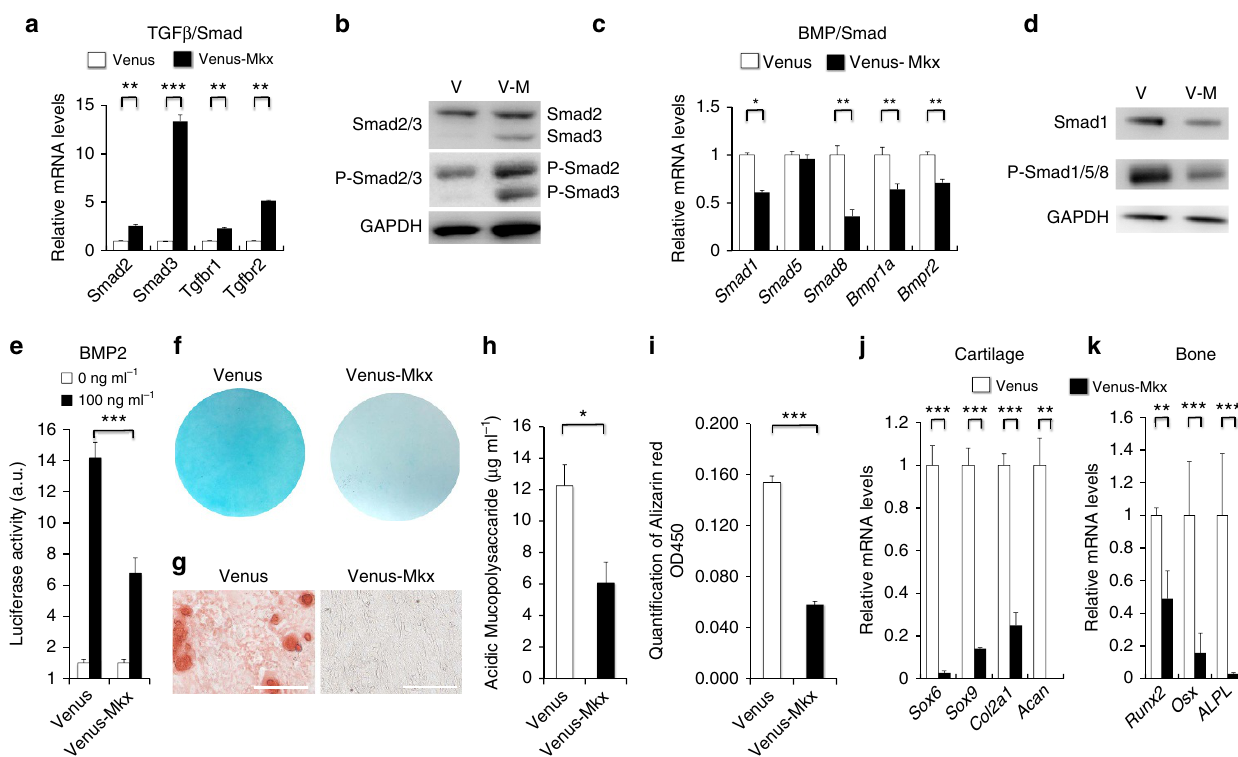
Figure 6 | Link between Mkx and TGF b and BMP signalling pathway component during ligament differentiation. ( a , c ) qRT–PCR analyses of the expression of TGF b /Smad- and BMP/Smad-related genes in C3H10T1/2-V and C3H10T1/2-VM cells. mRNA levels in C3H10T1/2-V cells were normalized to 1. Error bars represent s.e.m. * P o 0.05, ** P o 0.01, *** P o 0.001. Statistical differences were assessed with Student’s t -test. ( b , d ) Western blot analyses of C3H10T1/2-V and C3H10T1/2-VM cells. TGF b -dependent phosphorylation of Smads is shown by anti-p-Smad2/3 antibodies. BMP-dependent phosphorylation of Smads is shown by anti-p-Smad1/5/8 antibodies. ( e ) Luciferase assay to determine responsiveness to BMP2. Id1-Bre luciferase was transfected into C3H10T1/-V and C3H10T1/2-VM cells, followed by treatment with or without BMP2 (100ngml (cid:2) 1 ). Fold-induction values in the presence of BMP2 compared with the basal levels of each cell line are indicated. ** P o 0.01. Statistical differences were assessed with Student’s t -test. ( f – k ) C3H10T1/2-V and C3H10T1/2-VM cells were subjected to chondrocyte ( f , h , j ) and osteocyte ( g , i , k ) differentiation. ( f ) Alcian blue staining of C3H10T1/2-V and C3H10T1/2-VM cells after induction of chondrocyte differentiation. ( g ) Alizarin red staining of C3H10T1/2-V and C3H10T1/2-VM cells after induction of osteocyte differentiation. Scale bars, 200 m m. ( h ) Mucopolysaccaride quantification after chondrogenic induction. Error bars represent s.e.m. * P o 0.05. Statistical differences were assessed with Student’s t -test. ( i ) Calcification evaluation after osteogenic induction. Error bars represent s.e.m. *** P o 0.001. Statistical differences were assessed with Student’s t -test. ( j , k ) qRT–PCR analyses of mesodermal gene expression in C3H10T1/2-Vand C3H10T1/2-VM cells in the presence or absence of induction with BMP2. mRNA levels in C3H10T1/2-Vcells without induction were normalized to 1. Error bars represent s.e.m. ** P o 0.01, *** P o 0.001. Statistical differences were assessed with Student’s t -test. BMP, bone morphogenetic protein; TGF b , transforming growth factor b